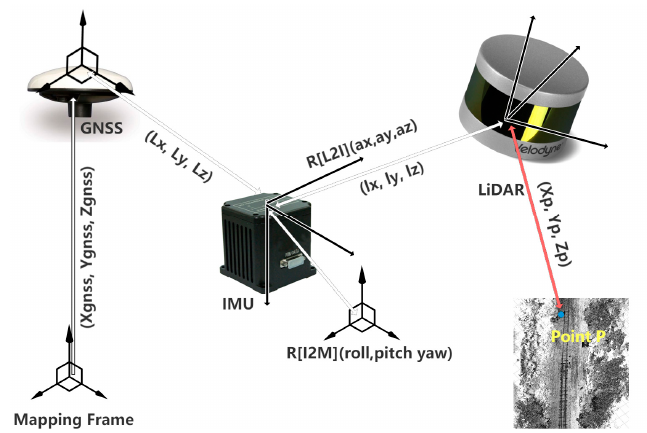
Figure 3. Principle of coordinate transform.